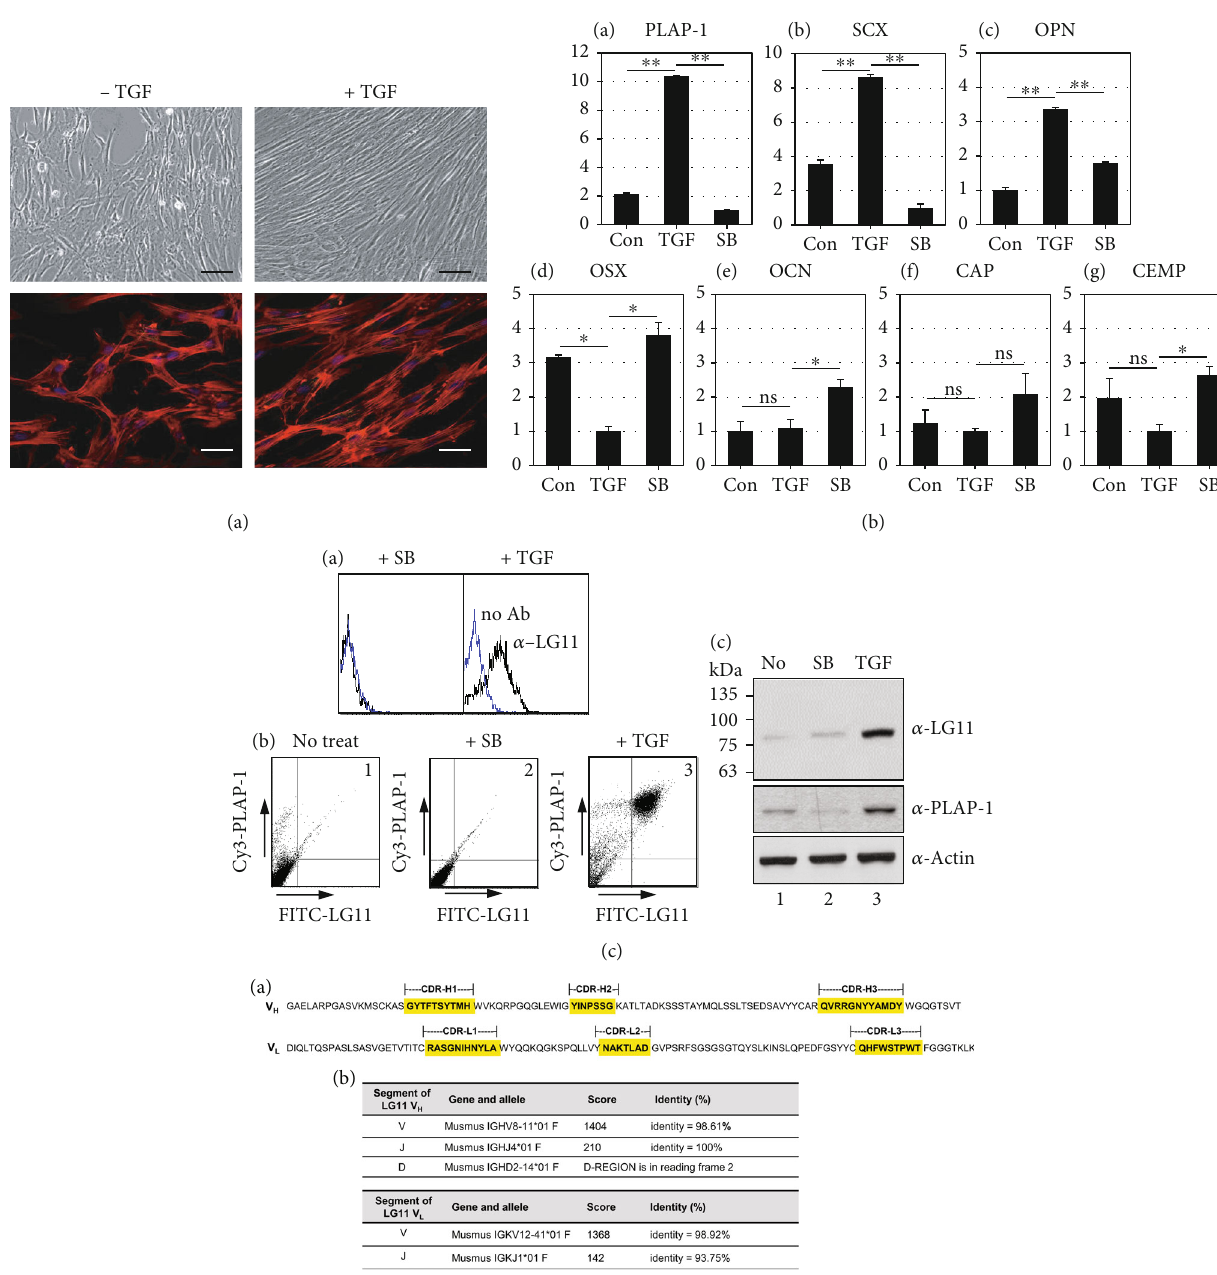
Figure 1: Antigenic molecule recognized by a novel anti-LG11 antibody was upregulated in the TGF- β 1-induced fi broblastic cells. (a) Cell morphological characterization. The morphologies (A) and cytoskeletal structures (B) of hPDLSC were observed before and after TGF- β 1 treatment. The cytoskeletal structure was shown as F-actin by phalloidin staining. (b) Evidence of successful PDL- fi broblastic di ff erentiation derived from hPDLSCs. PDL- fi broblastic and osteo/cementoblastic marker expressions in hPDLSCs were veri fi ed by transcriptional levels. Quantitative RT-PCR analysis is performed to determine the gene expression in cells treated with TGF- β 1 (TGF) and/or its receptor inhibitor, SB431542 (SB). Statistical signi fi cance is determined using the student ’ s t - test. ns: not signi fi cant; ∗ P < 0 : 05 ; ∗∗ P < 0 : 01 . (c) Antigen recognized by anti-LG11 antibody as a PDL fi broblast-speci fi c molecule. (A) LG11 antigen speci fi cally interacted with TGF- β 1- induced PDL- fi broblastic progenitors (TGF), not with SB431542-treated cells (SB). (B) TGF- β 1-induced PDL- fi broblastic progenitors were double positive of Cy3-PLAP-1 and FITC-LG11. 1: undi ff erentiated cells; 2: SB431542-treated hPDLSCs; 3: TGF- β 1-induced PDL- fi broblastic progenitors. In (C), the amount of the endogenous LG11 antigen was signi fi cantly increased in total cell extract obtained from PDL- fi broblastic progenitors. (d) Sequence information and identity analysis of the variable regions of anti-LG11 antibody. (A) Amino acid sequences of mouse immunoglobulin heavy and light chain variable regions. Three complementarity determining regions in heavy and light chains (CDR-H1 ~ 3 and CDR-L1 ~ 3) were shown in shading boxes. (B) IMGT/V-QUEST database-based antibody similarity